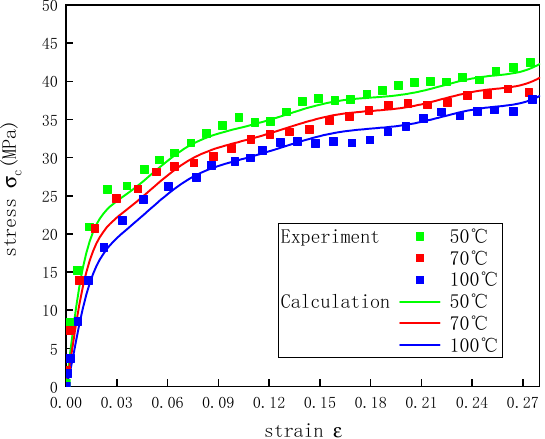
Figure 13. Stress–strain curves of UHMWPE at a strain rate of 2200 s − 1 and different temperatures.